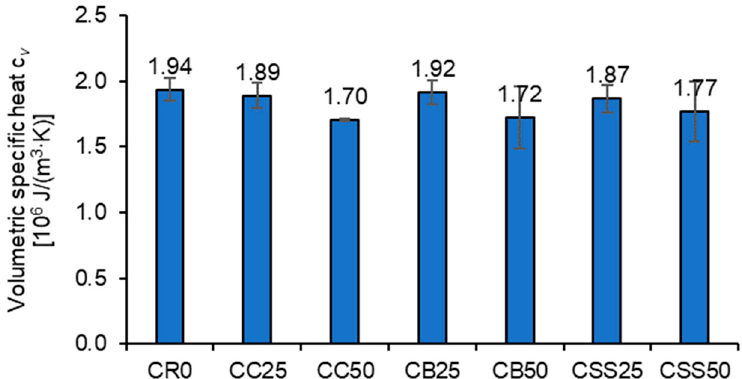
Figure 14. The average values of volumetric specific heat of the tested composites.